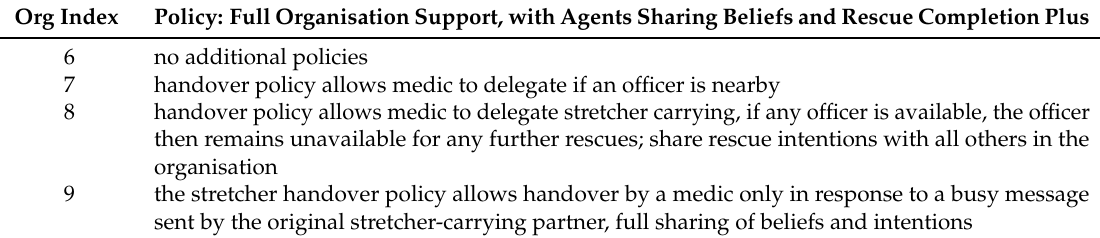
Table 6. Organisation handover policy settings—12-room simulations.